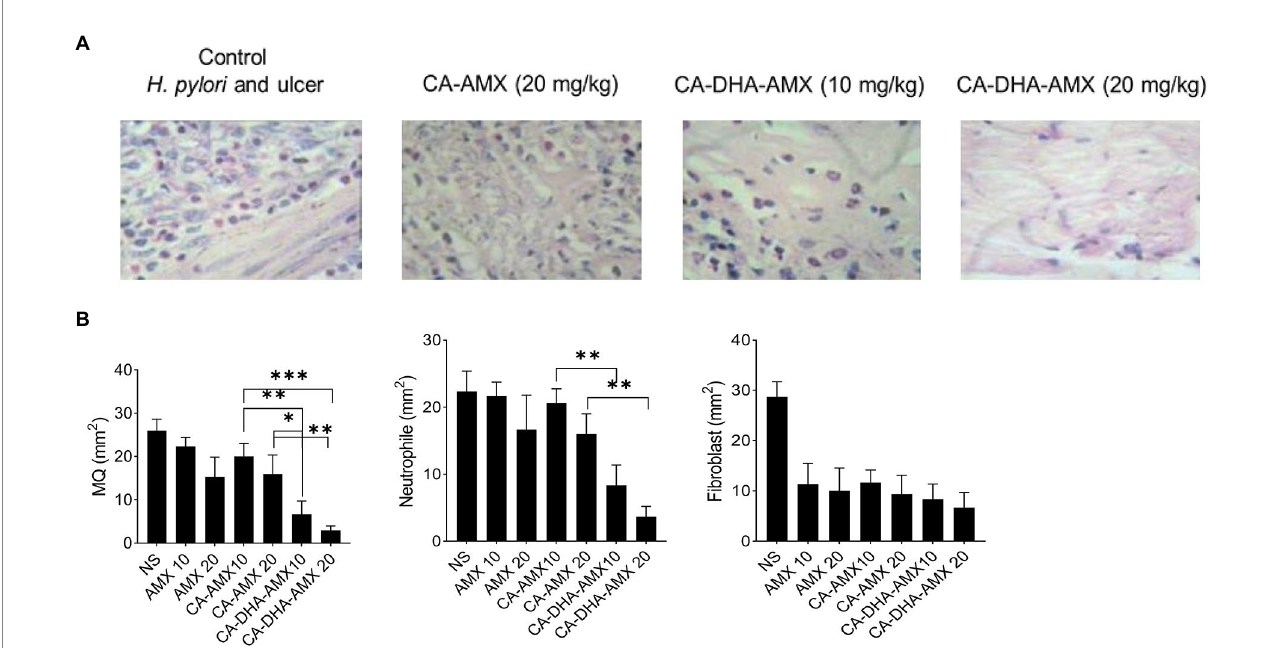
FIGURE 7 The distribution of macrophage (MQ), neutrophil and fibroblast cells. (A) The microscopic distribution of macrophage, neutrophil and fibroblast cells in four different group untreated group, CA-AMX (20 mg/kg), CA-DHA-AMX (10 mg/kg), and CA-DHA, AMX (20 mg/kg) at 14. Hematoxylin and Eosin staining. (B) The comparison of macrophage, neutrophil and fibroblast cells at day 14 among all treated groups. Data are presented as mean ± SEM ( n =